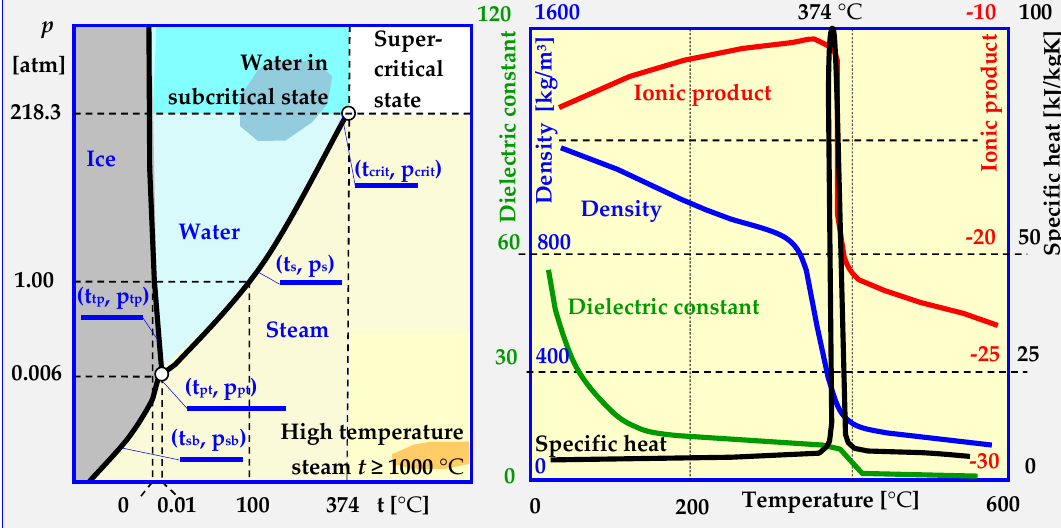
Figure 21. Water phase diagram and its properties in normal, high temperature, subcritical and supercritical states [17,73,165].